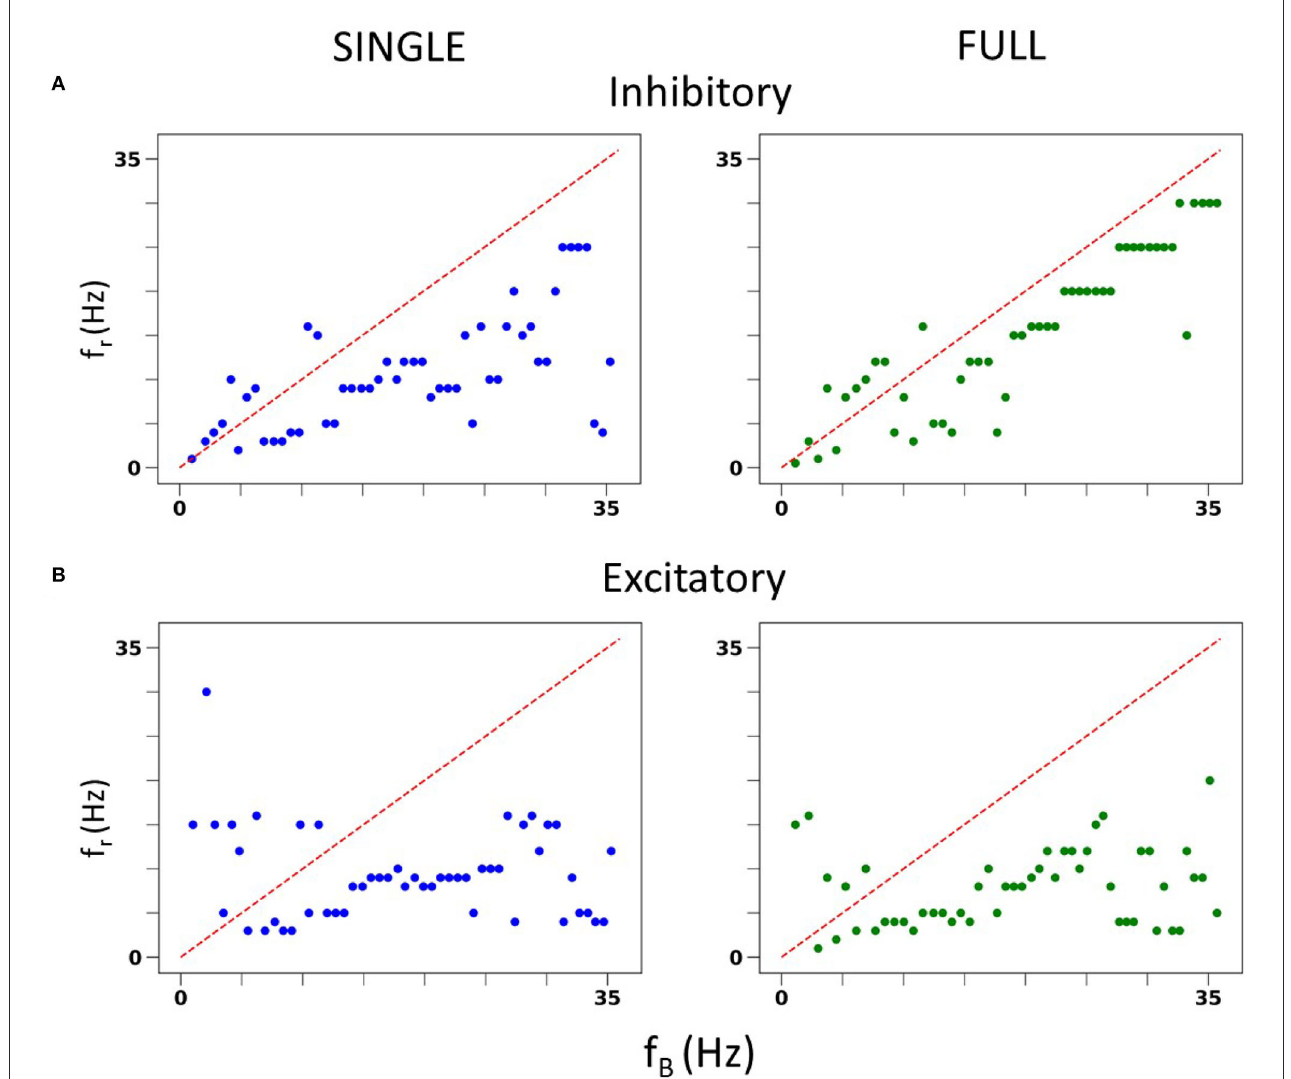
FIGURE4 In vitro spiking resonance pattern in SINGLE is comparable to FULL. (A) Resonant frequency ( f r ) of inhibitory perturbations at different baseline firing rates ( f B ). Blue is from single compartment model, green is from full model. (B) Resonant frequency ( f r ) of excitatory perturbations at different baseline firing rates ( f B ). Blue is from single compartment model, green is from full